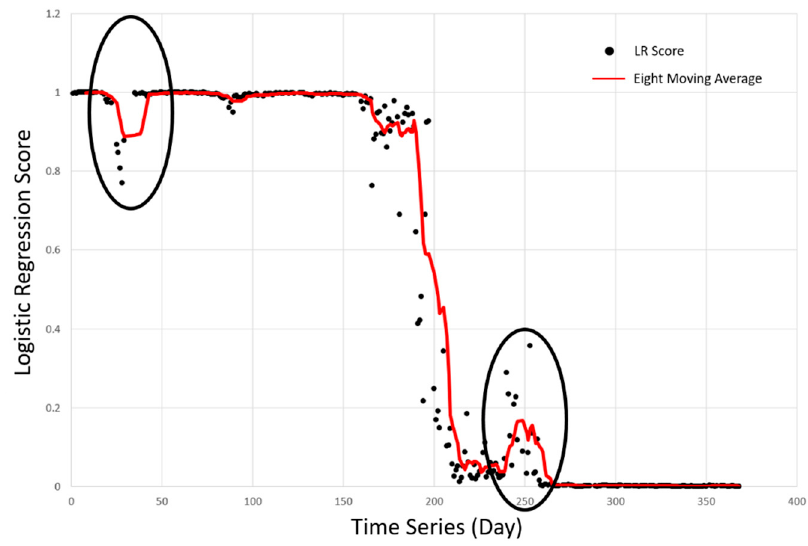
Figure 12. LR score (CV) for the RUL of the WHRA obtained by the LR model.